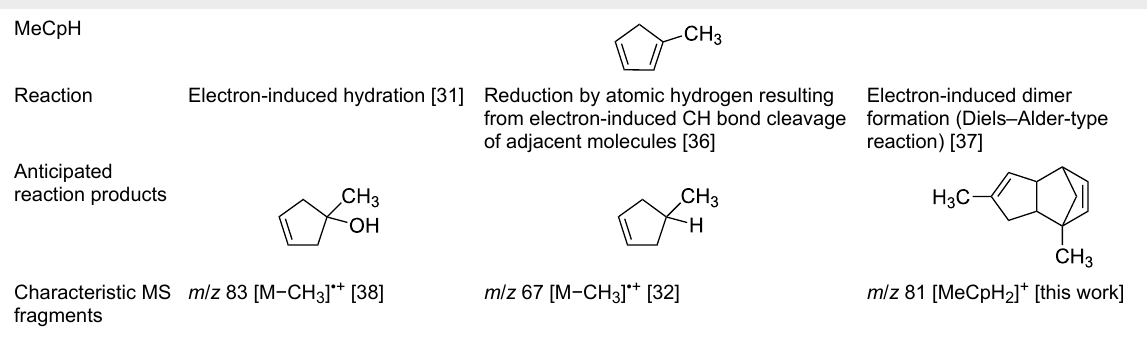
Table 1: Anticipated products of electron-induced reactions of pure MeCpH or of MeCpH in presence of H 2 O. MeCpH